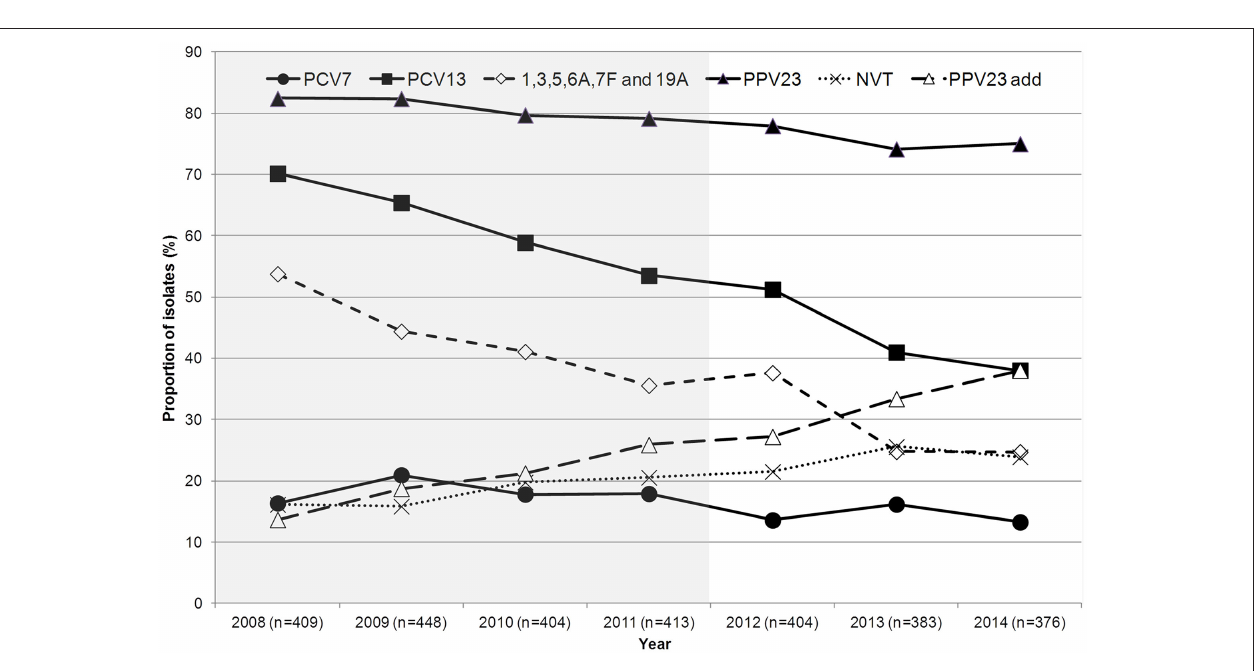
In contrast to these serotypes, there was no overall reduction of serotype 3. These results are concordant with other studies that failed to show a consistent reduction of serotype 3 among